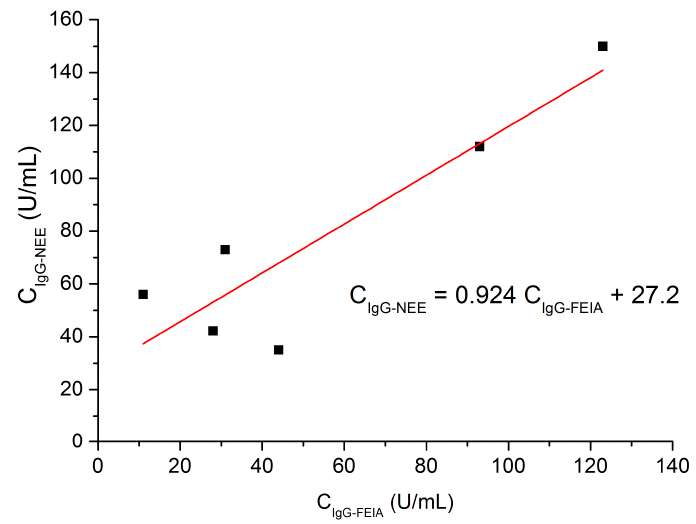
Figure 9. Correlation plot between anti-tTG IgG activities measured by the electrochemical immunosensor (C IgG-NEE ) vs. FEIA analysis (C IgG-FEIA ) in human serum samples.